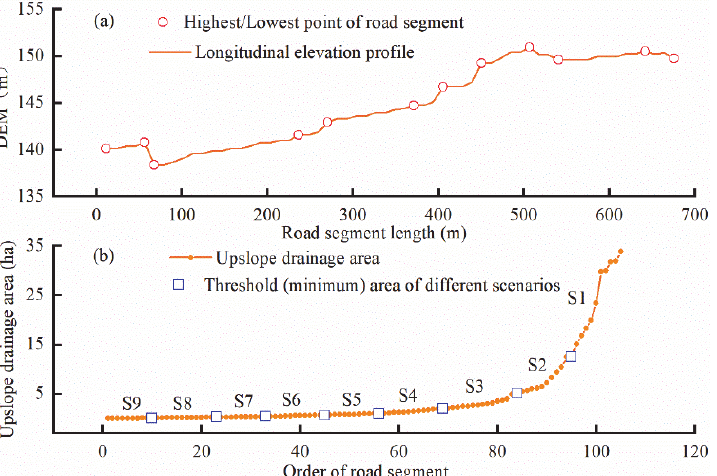
Figure 4. Schematic of a forest road segment’s longitudinal elevation profile ( a ) and road segments with different lengths but the same elevation change, prioritized by their drainage area ( b ).